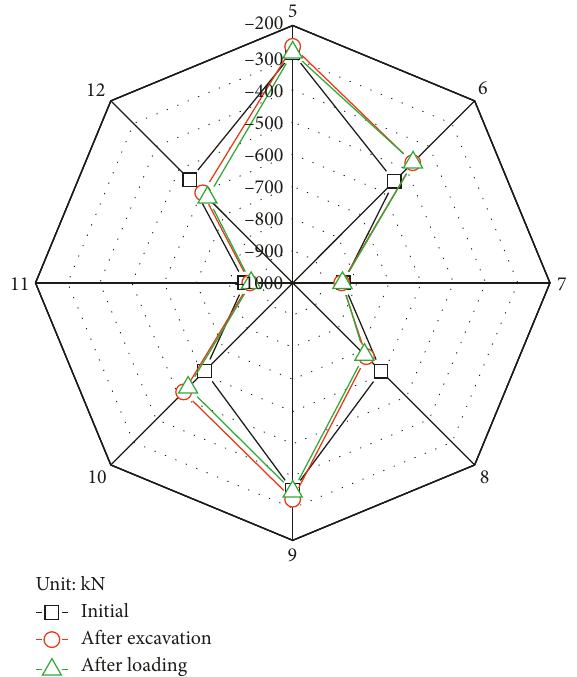
Figure 17: Normal forces of the tunnel structure in scheme 0.